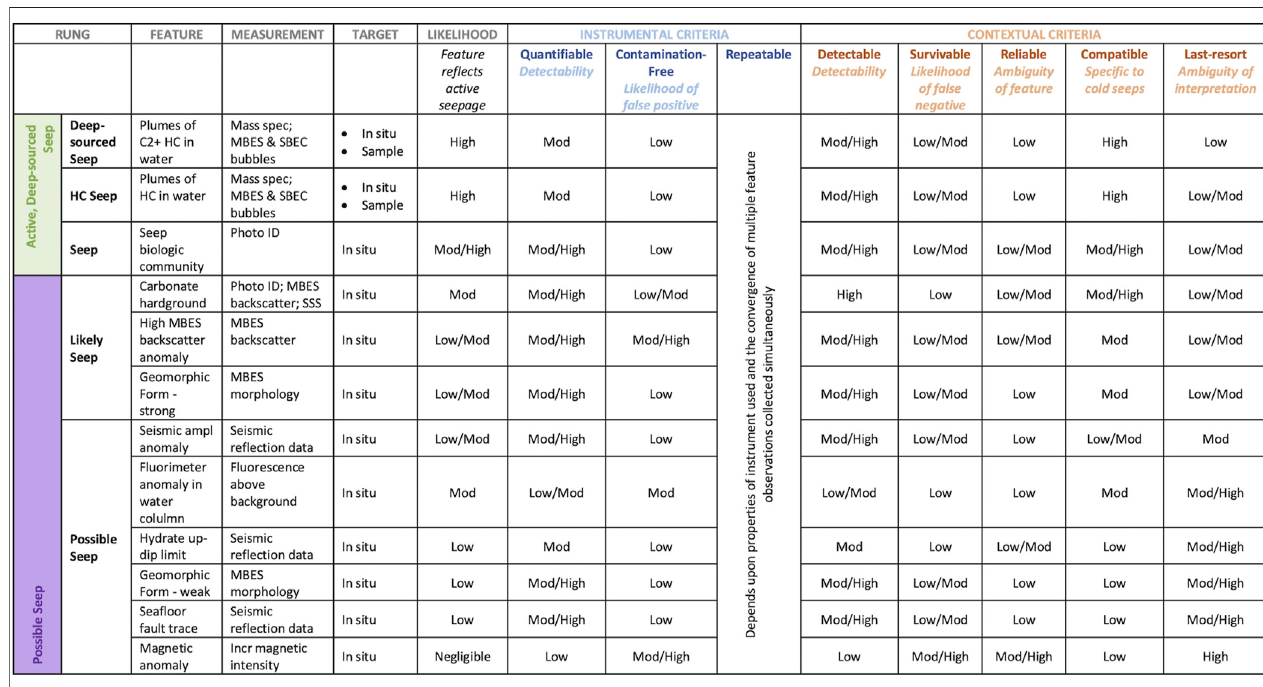
FIGURE 2 | Ladder of Seeps. Conceptual framework for exploring for speci fi c seep types. Lower part of table de fi nes exploration progression from Possible to LikelySeep,andupperpartdescribesdifferenttypesofactiveseepswitheachhigherrungrepresentingsubsetofseeptypebelow.Tablecolumnsincludetypeoffeature observed in nature (Feature), what type of Measurement is made to detect feature, whether measurement is made above sea fl oor or below (Target), and Likelihood that proposed Feature describes Ladder Rung. Issues of Instrumental Criteria include whether proposed Feature is Quanti fi able (Detectable), Contamination-Free (False Positive) and Repeatable. Contextual Criteria represent an explicit evaluation of scienti fi c method by considering whether feature is Detectable, Survivable (False Negative),Reliable,Compatible(i.e.speci fi ctonaturalcoldseeps),andLast-Resortinterpretation(i.e.doesevidencerefuteallotherpossiblehypotheses).Deep-sourced fl uids are placed at top of ladder in this instance to identify locations for earthquake studies, but ladder could be modi fi ed for other scienti fi c